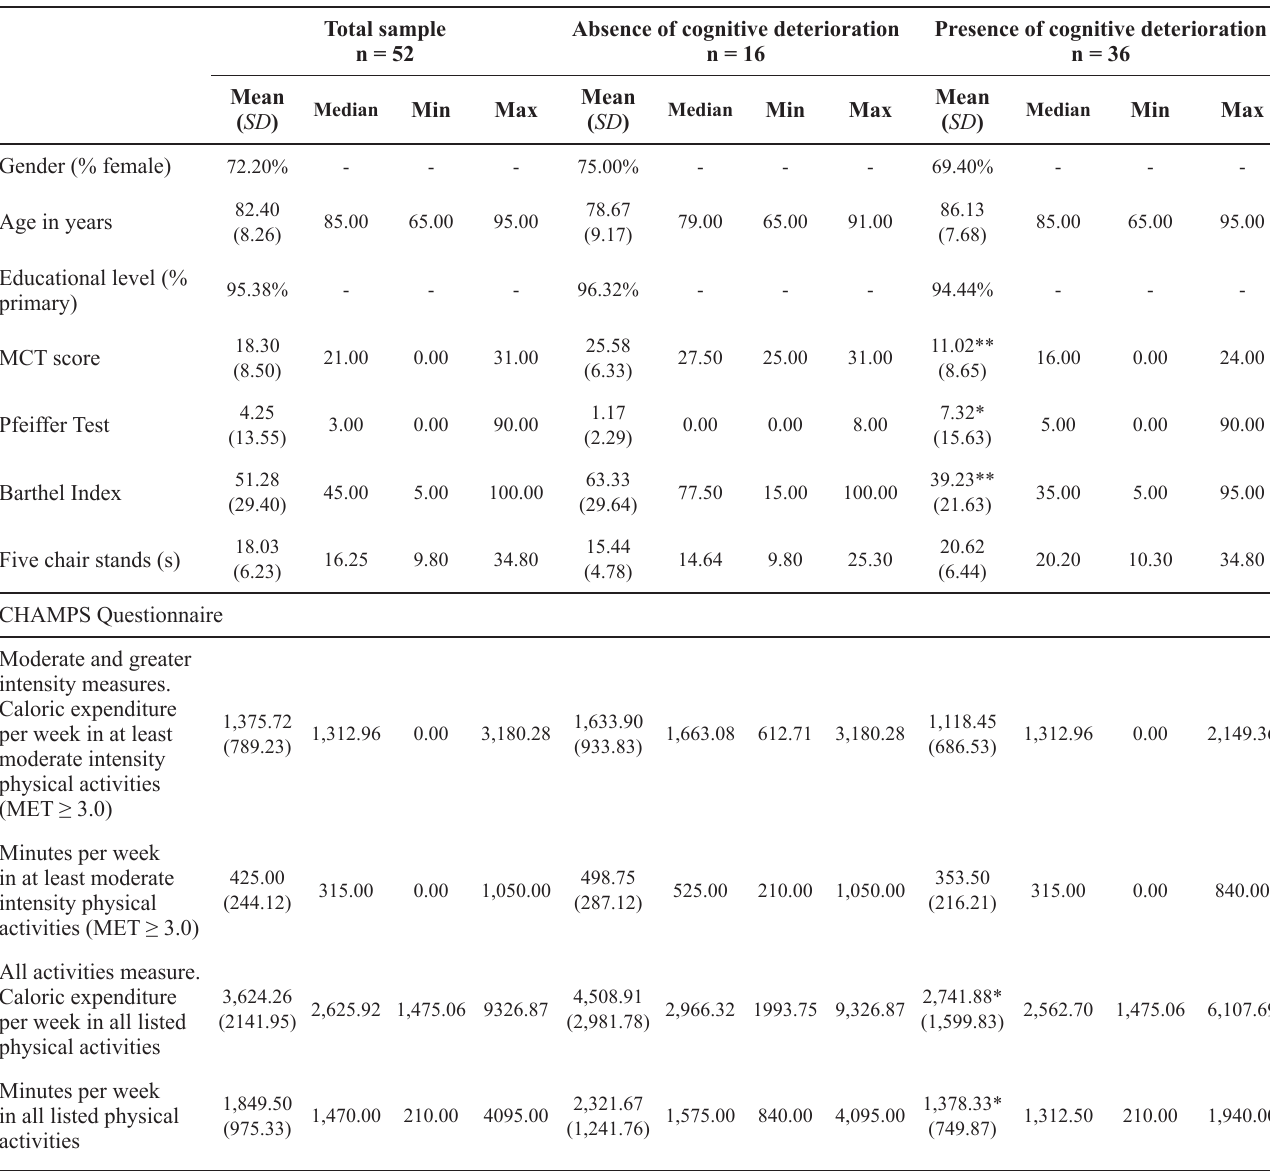
Table 1 Characteristics and mean values obtained from the sample relative to the presence or absence of cognitive